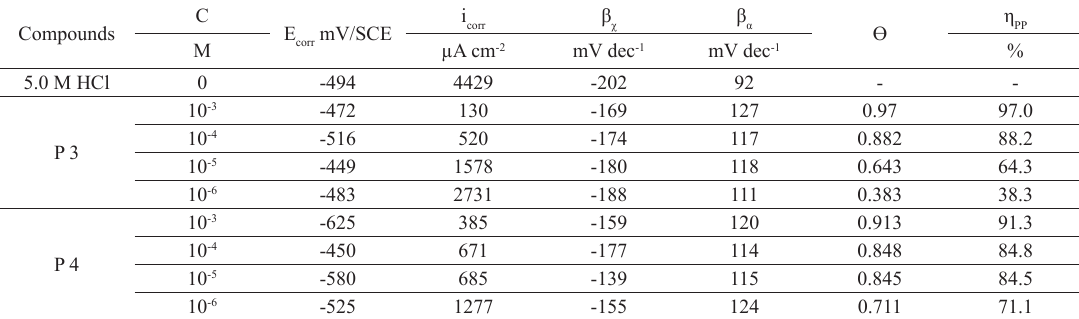
Table 2. Electrochemical parameters and inhibition efficiency values for ordinary steel in 5.0 M HCl solution without and with P3 or P4 addition at different concentrations. Compounds